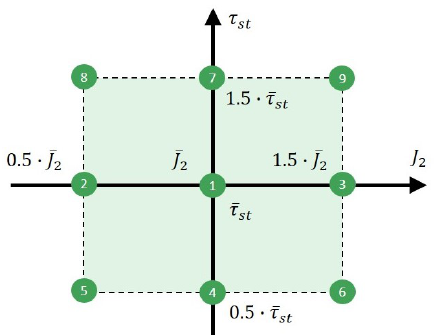
Figure 15. Domain of parameters variation and simulation cases.